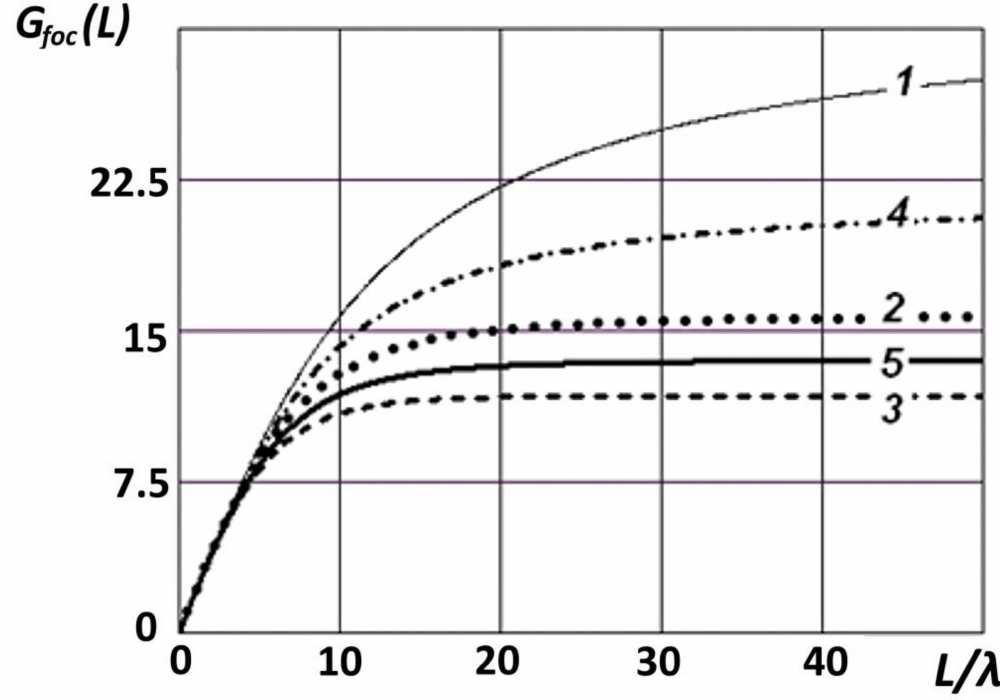
Figure 9. Dependence of the directivity factor on the size of the aperture for the optimal amplitude distribution and various RPs of the elementary